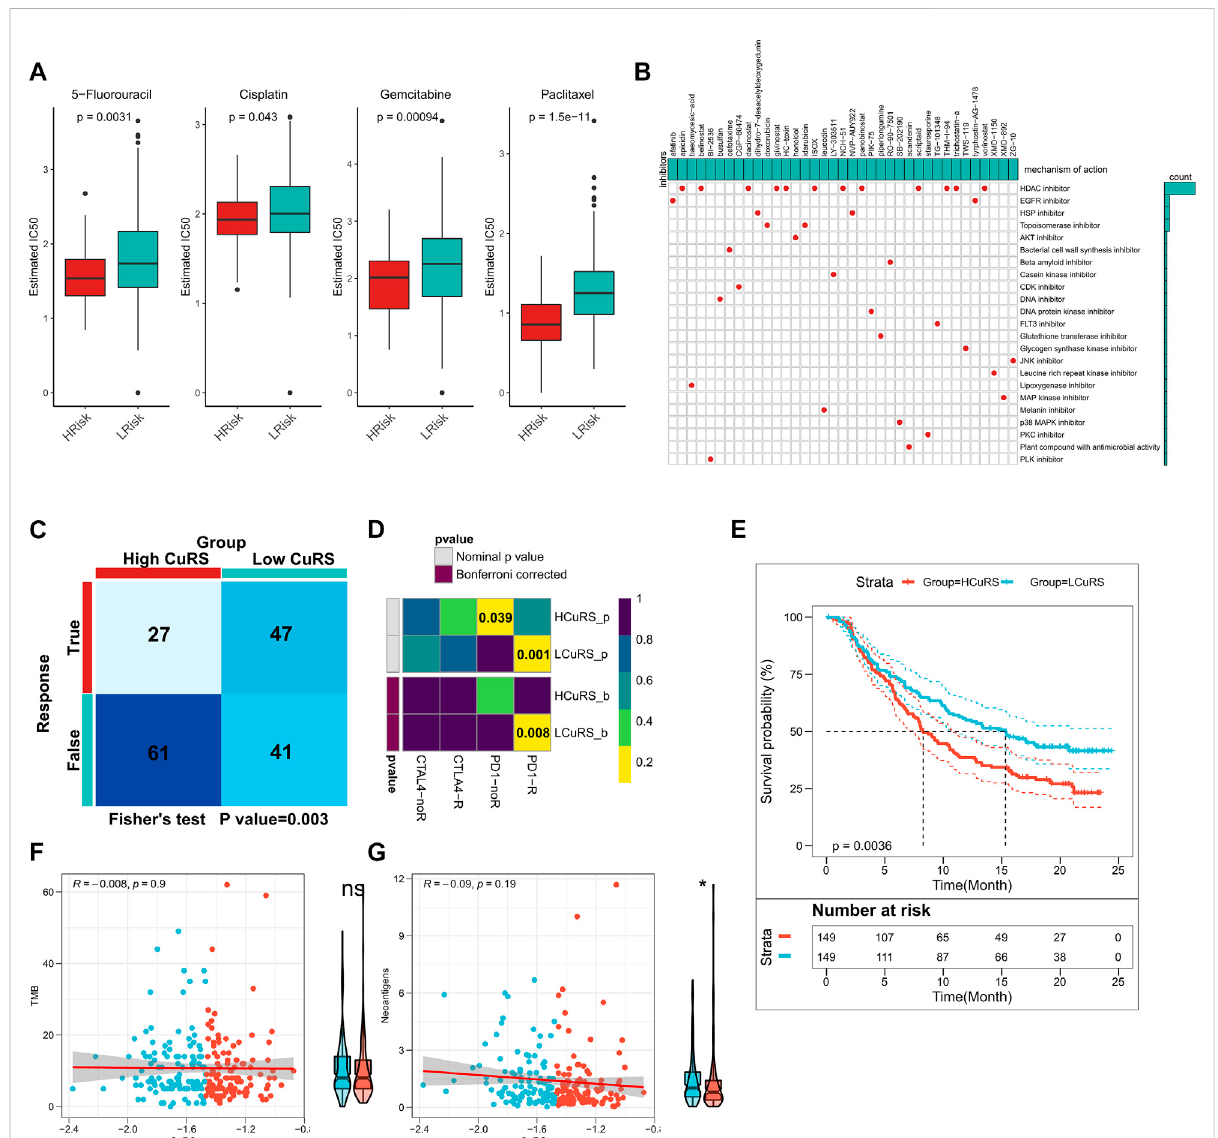
FIGURE 7 Role of CuRS in clinical decision-making. (A) Box plot showing the predicted IC 50 values for four commonly used drugs between the high- and low-CuRS groups; (B) Oncoplot showing the identi fi ed small molecule compounds, where the horizontal axis represents the name of the small molecule inhibitor and the vertical axis represents the biological pathway targeted by the corresponding small molecule inhibitors; (C) TIDE algorithm to predict the responses of patients in the high- and low-CuRS groups to immunotherapy; (D) Subclass mapping to predict the sensitivitiesofpatients inthehigh-andlow-CuRSgroupstoPD1andCTLA4treatments; (E) KMsurvivalcurves forthehigh-andlow-CuRSgroupsin the IMvigor210 cohort; (F) Correlation between CuRS and TMB in the IMvigor210 cohort; (G) Correlation between CuRS and neoantigens in the IMvigor210